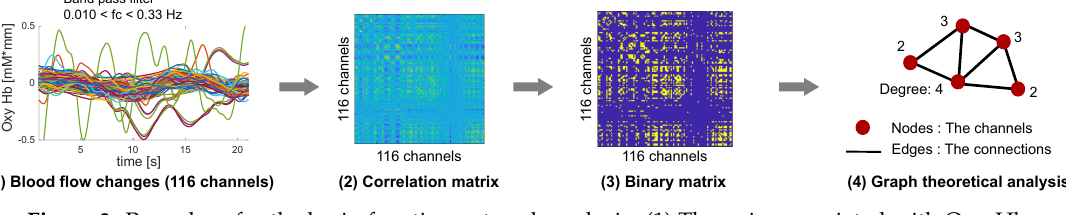
Figure 3. Procedure for the brain function network analysis. (1) The noise associated with Oxy-Hb changes (116 channels) was removed by pre-processing. (2) Pearson correlation matrix of Oxy-Hb concentration changes was calculated. (3) The correlation matrix was binarized by threshold (edge density of 15%). (4) Network feature amount (degree) was calculated based on graph theory. The red dots indicate nodes and the lines indicate edges. The numerical values indicate the number of nodes connected by other